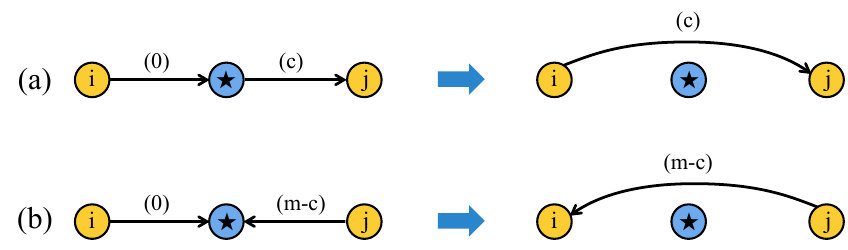
Figure 16. a) Composition of arrows into a meson. b) The same process interpreted as anticom- position.